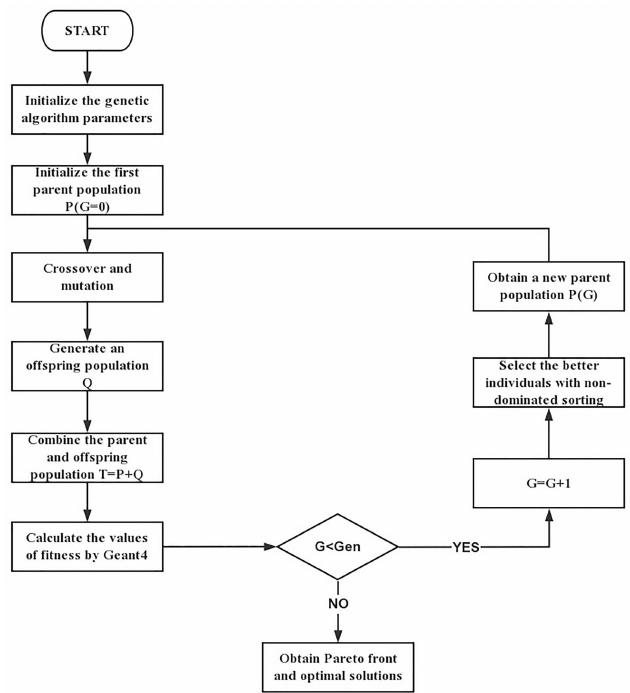
Figure 4 Flow chart of the genetic